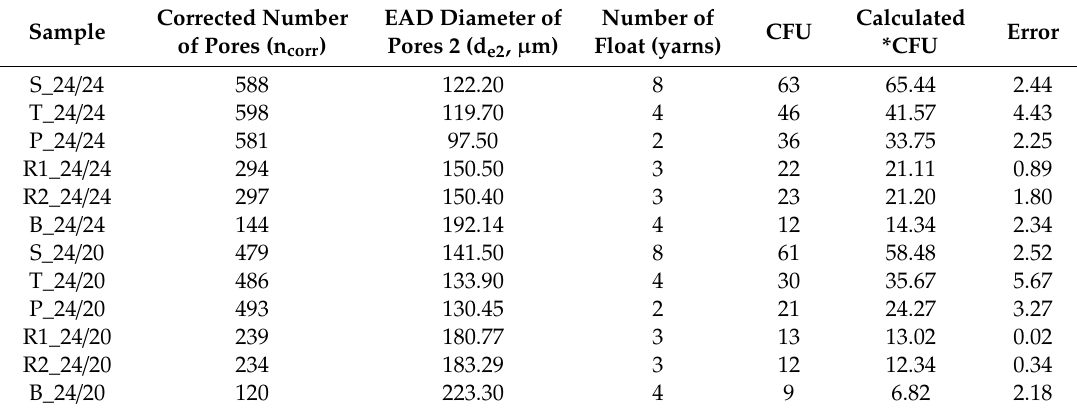
Table 10. Multiple linear regression of samples with densities of 24 / 24 and 24 / 20 taken